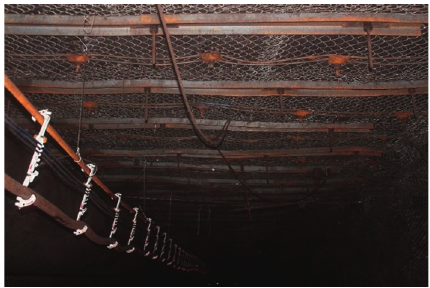
Figure 7: Control effect of the surrounding